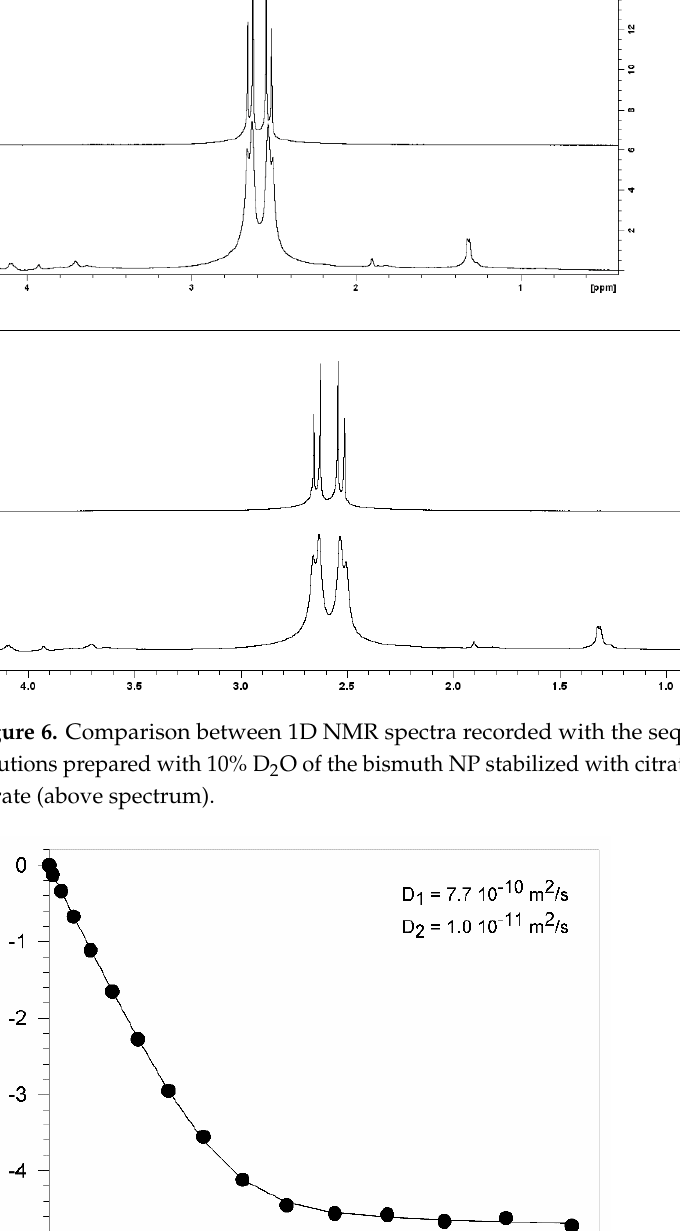
citrate and compared to the spectrum of citrate (Figure 6). These spectra clearly evidence